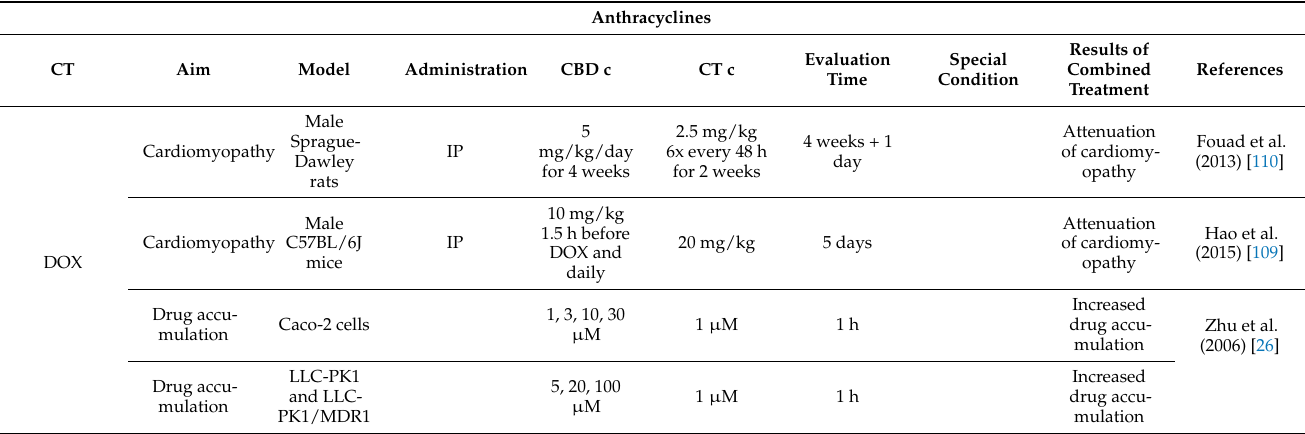
Table 4. Summary of the drug–drug interactions of CBD with